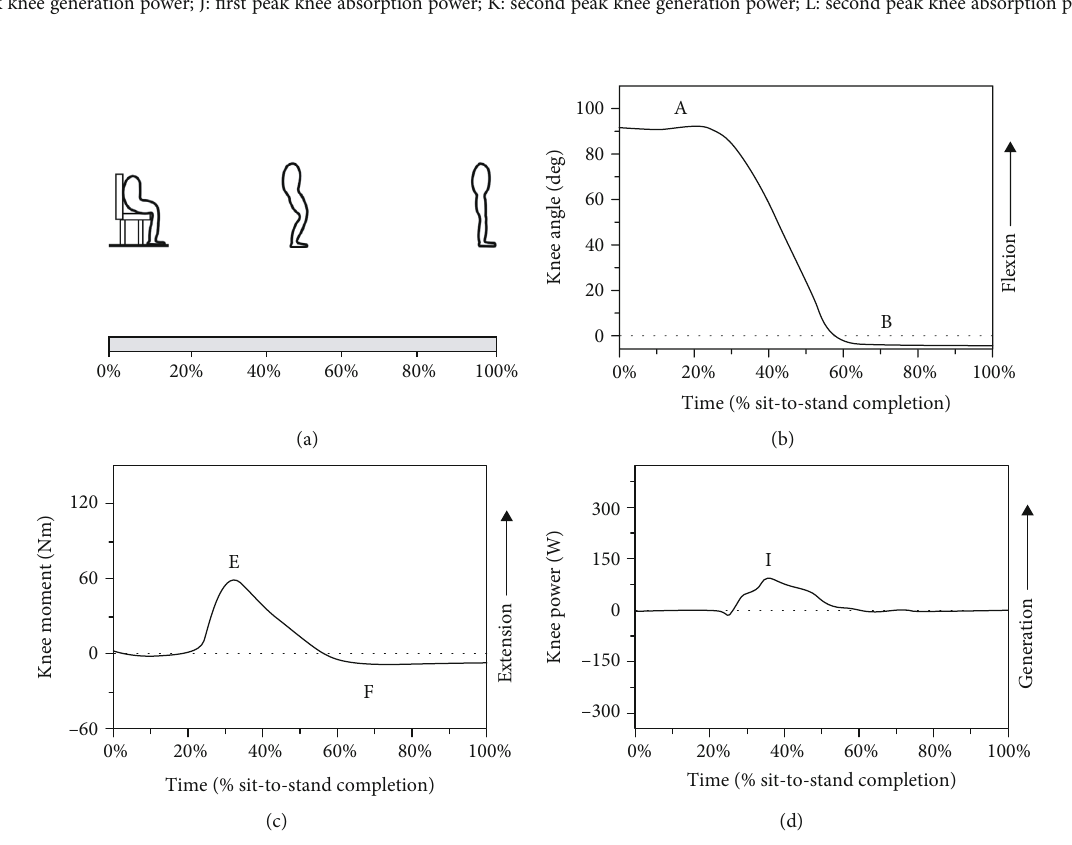
Figure 5: A sketch map of motion and the typical curves of knee angle, moment, and power in the sagittal plane for sit-to-stand. (a) Sketch map of sit-to-stand cycle [28]. (b) Knee angle-time curve ((A) peak knee fl exion angle and (B) peak knee extension angle). (c) Knee moment- time curve ((E) peak knee extension moment and (F) peak knee fl exion moment). (d) knee power-time curve ((I) peak knee generation power) [37,